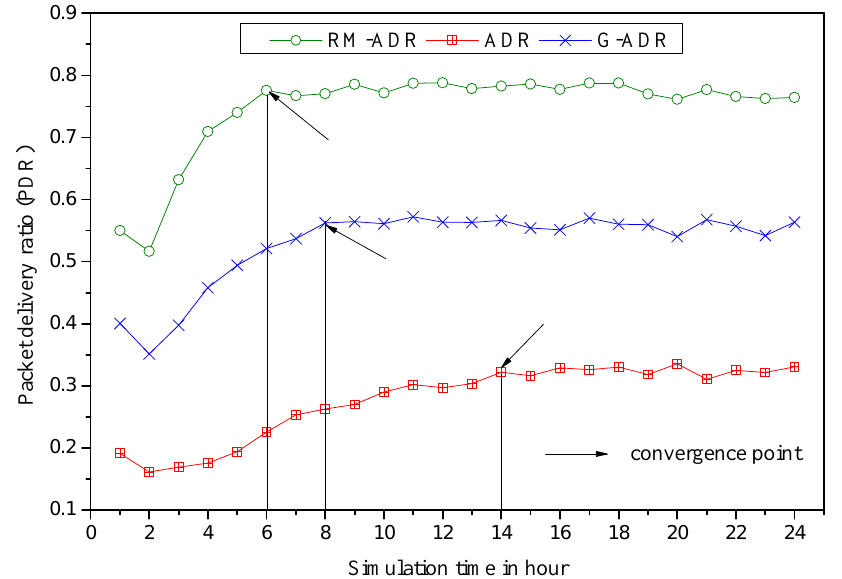
Figure 10. Convergence Period of the proposed RM-ADR and existing